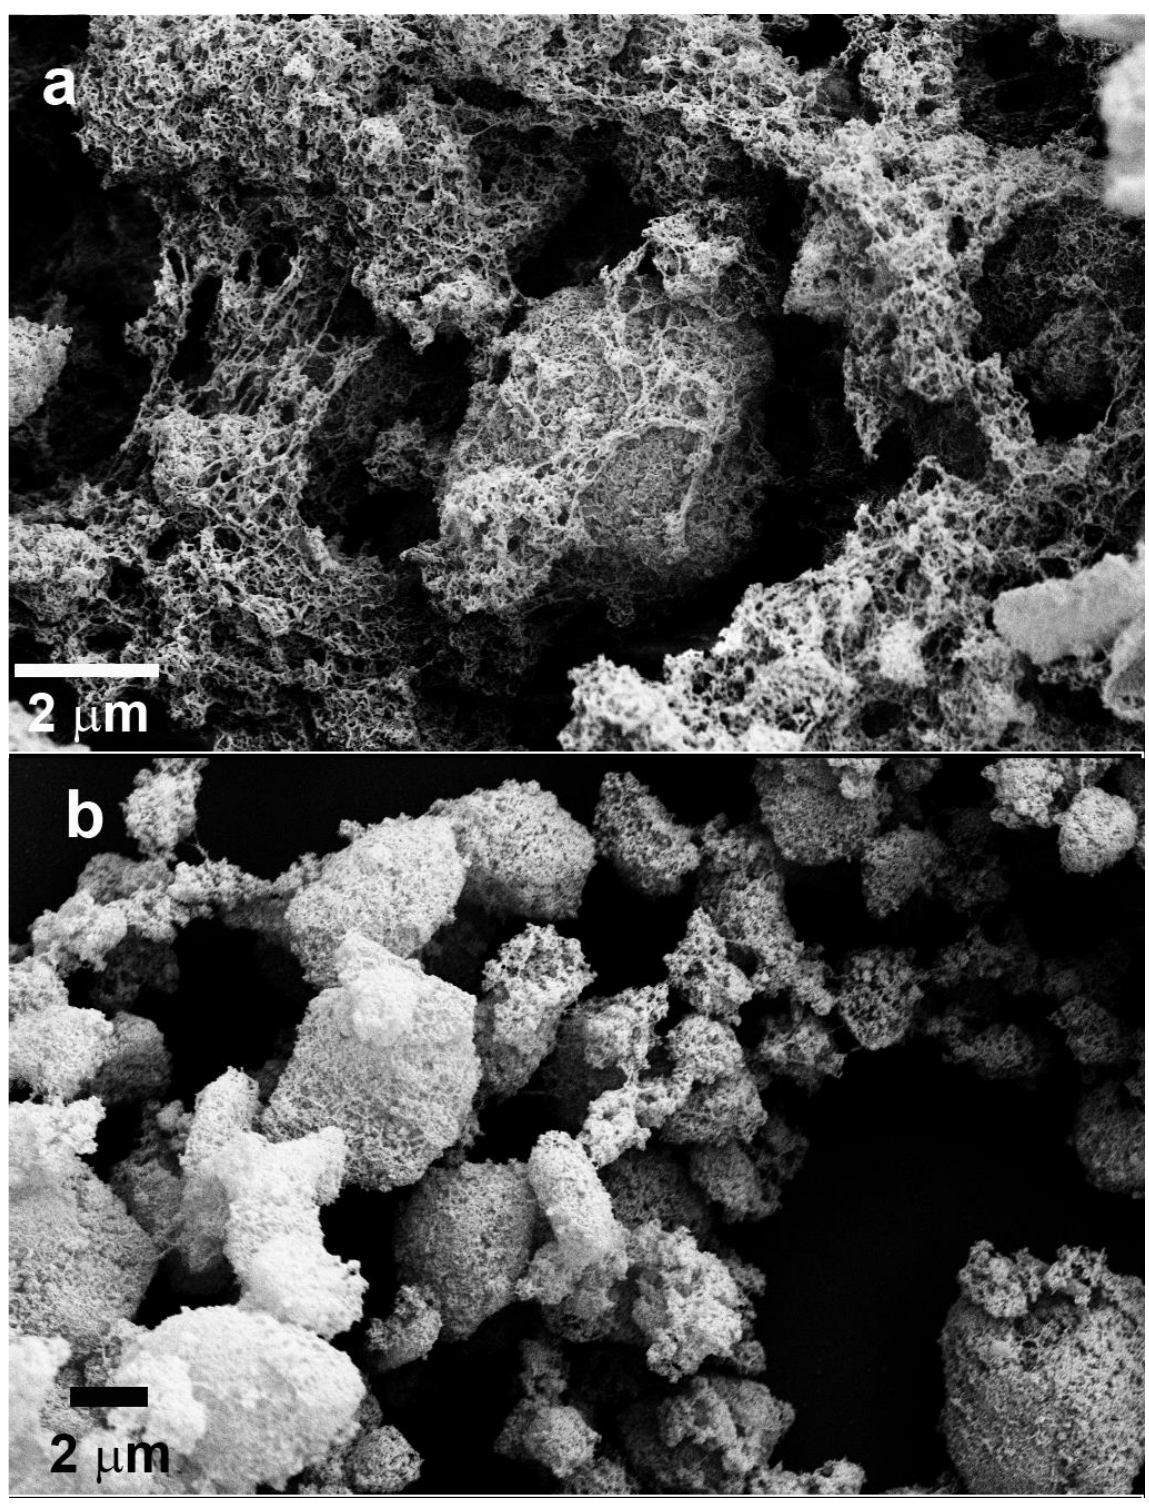
Figure 5. SEM image of S. putrefaciens with bioreduced HFO or ferric citrate in the presence of laponite nanoparticles showing biofilm and aggregated nanoparticles. ( a ) HFO with laponite and S. putrefaciens cells, ( b ) ferric citrate with laponite and S. putrefaciens cells. HFO, ferrihydrite.